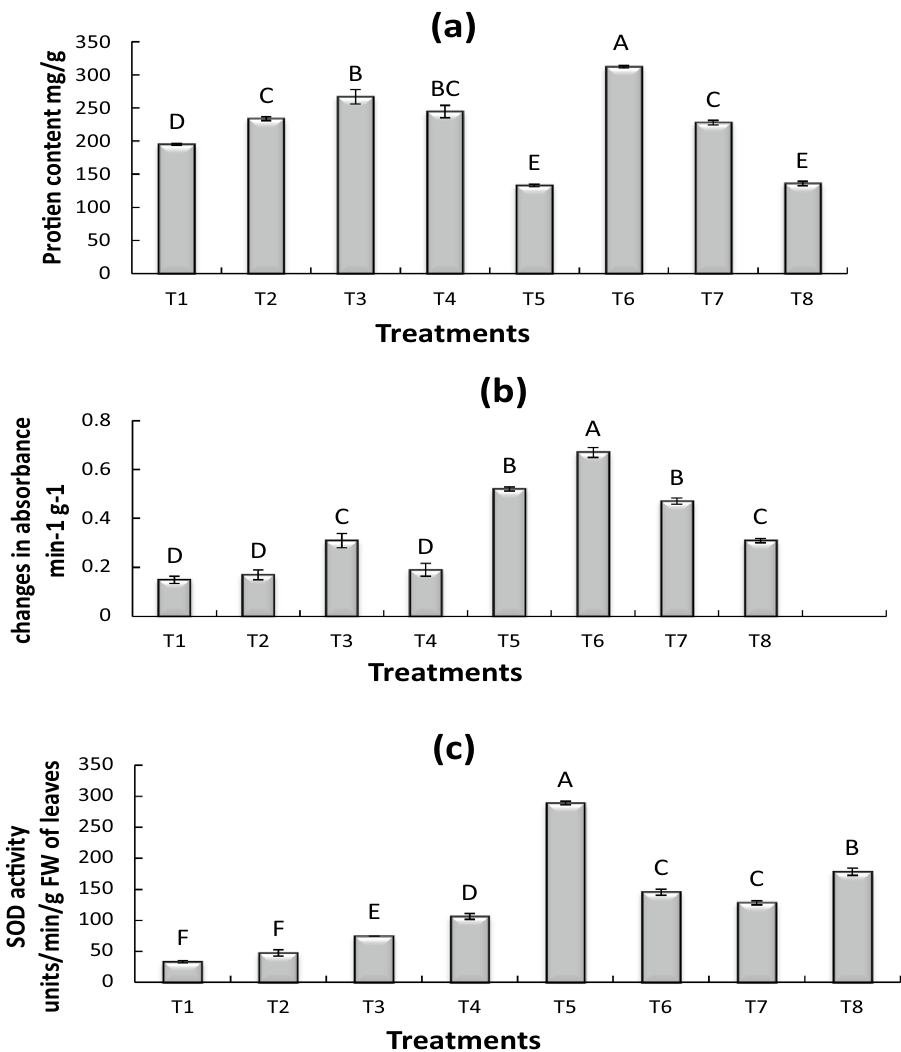
Figure 2. Effect of Cadmium (Cd) on maize protein ( a ), antioxidant enzymes peroxidase dismutase ( b ) and super oxidase dismutase ( c ). All treatments sharing common letter with similar bar pattern are similar otherwise differ significantly at p < 0.05. T1 = control, T2 = inoculated seed, T3 = 0.25 mg CdSO 4 100 mL −1 + uninoculated seed, T4 = B = 0.50 mg CdSO 4 100 mL −1 + uninoculated seed, T5 = 0.75 mg CdSO 4 100 mL −1 + uninoculated